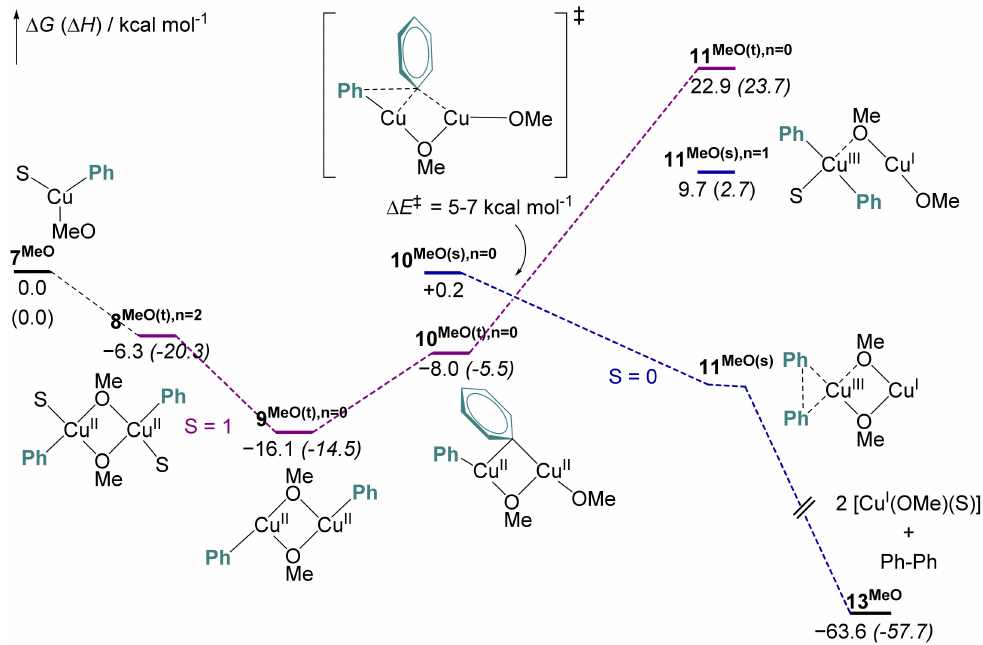
Figure 7. Gibbs energy profile of the Cu-to-Cu second transmetalation and subsequent reductive elimination computed at the DFT level (see the computational details). ∆ G ( ∆ H ) are given in kcal mol − 1